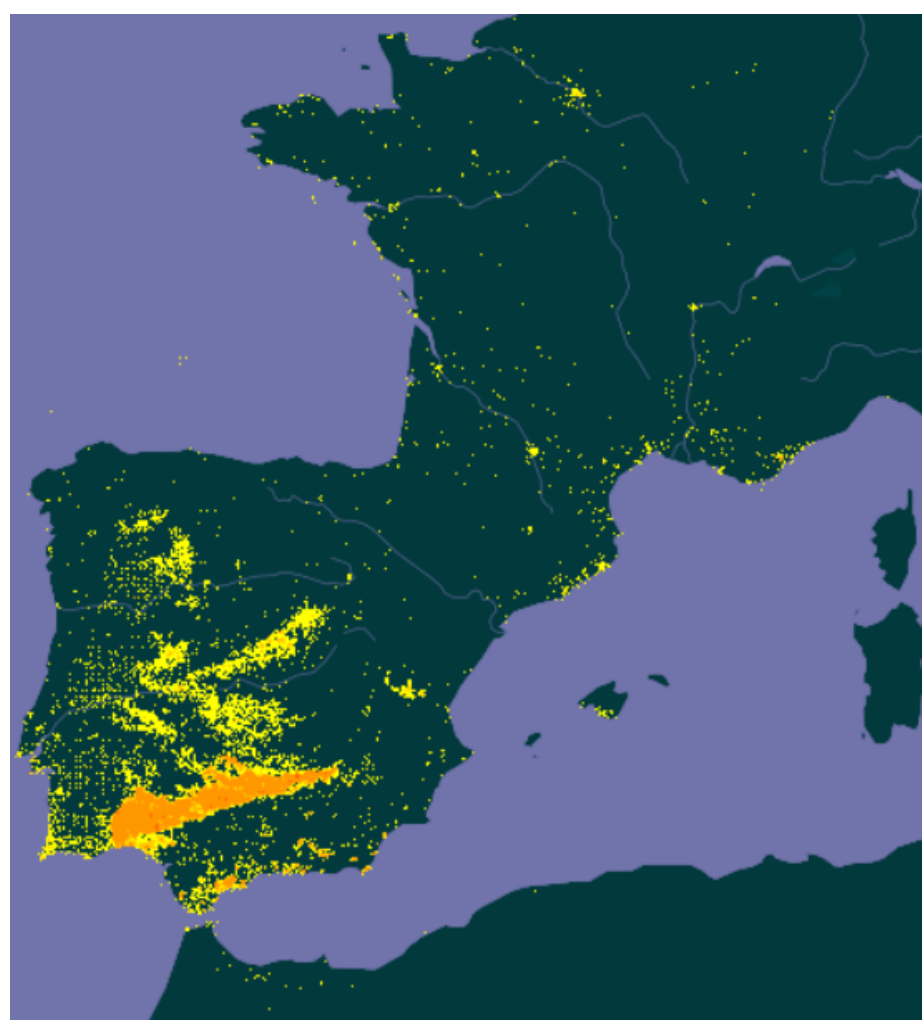
Figure 1. Distribution of Cistus ladanifer in Spain and other southern areas according to GBIF (Global Biodiversity Information Facility) [13].